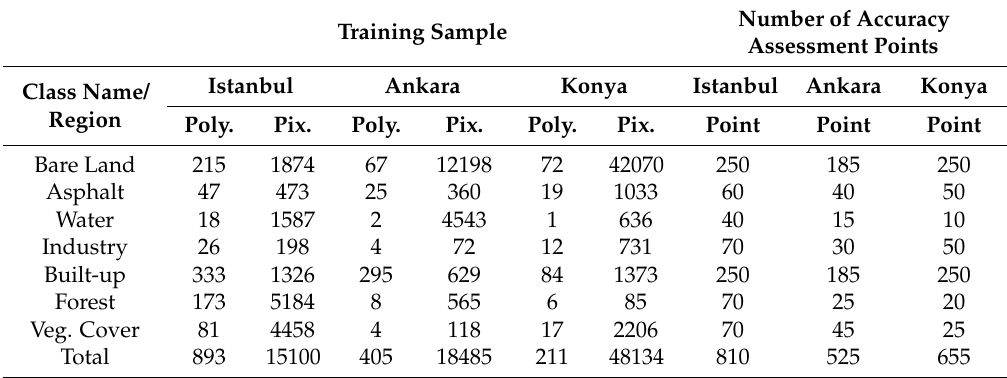
Table 3. Training sample and accuracy assessment point distribution for the study